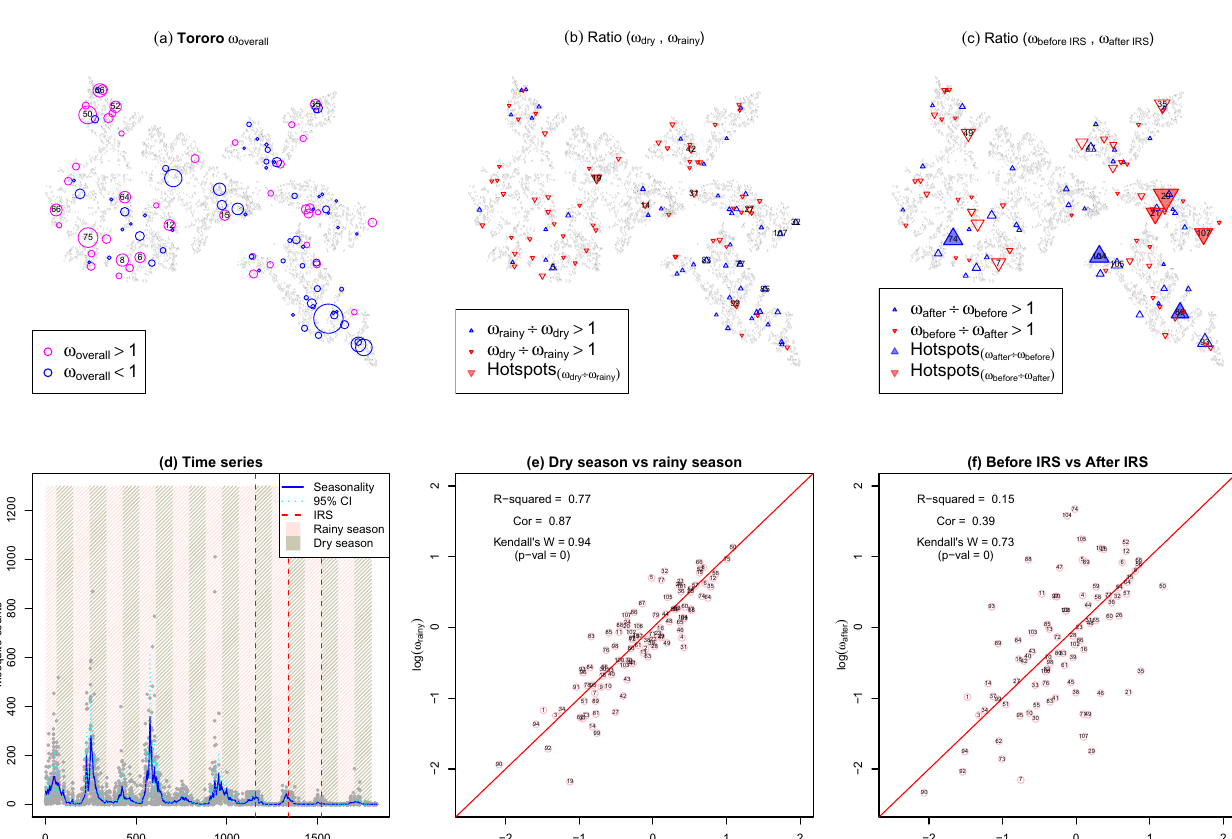
Figure 5. Tororo. The layout of the figure is the same as in Figure 3 with some exceptions as follows. ( a ): Blue circles denote households with ω < 1 with the size of the circles showing the magnitude of 1/(2 × ω ) to make their sizes comparable to the pink overall overall circles. Households with the largest ω include HH75, HH50, HH56, and HH52. ( c ) Ratios of household biting propensities before the overall deployment of IRS ( ω ) and after the deployment of IRS ( ω ). Each plotted upward pointing blue triangle represents a household before IRS after IRS with a larger ω after the deployment of IRS compared to before the deployment of IRS; a blue filled triangle denotes a hotspot for the ratio of ω / ω . Each plotted downward pointing red triangle represents a household with a larger ω before the deployment of IRS after IRS before IRS compared to after the deployment of IRS; a red filled triangle denotes a hotspot for the ratio of ω / ω . ( d ) The red vertical before IRS after IRS dashed lines denote the deployment of IRS which were six months apart. A strong seasonal signal was observed in Tororo. ( f ) Scatter plot of log( ω ) and log( ω ) along with measures of R 2 , correlation, and Kendall’s W before IRS after IRS